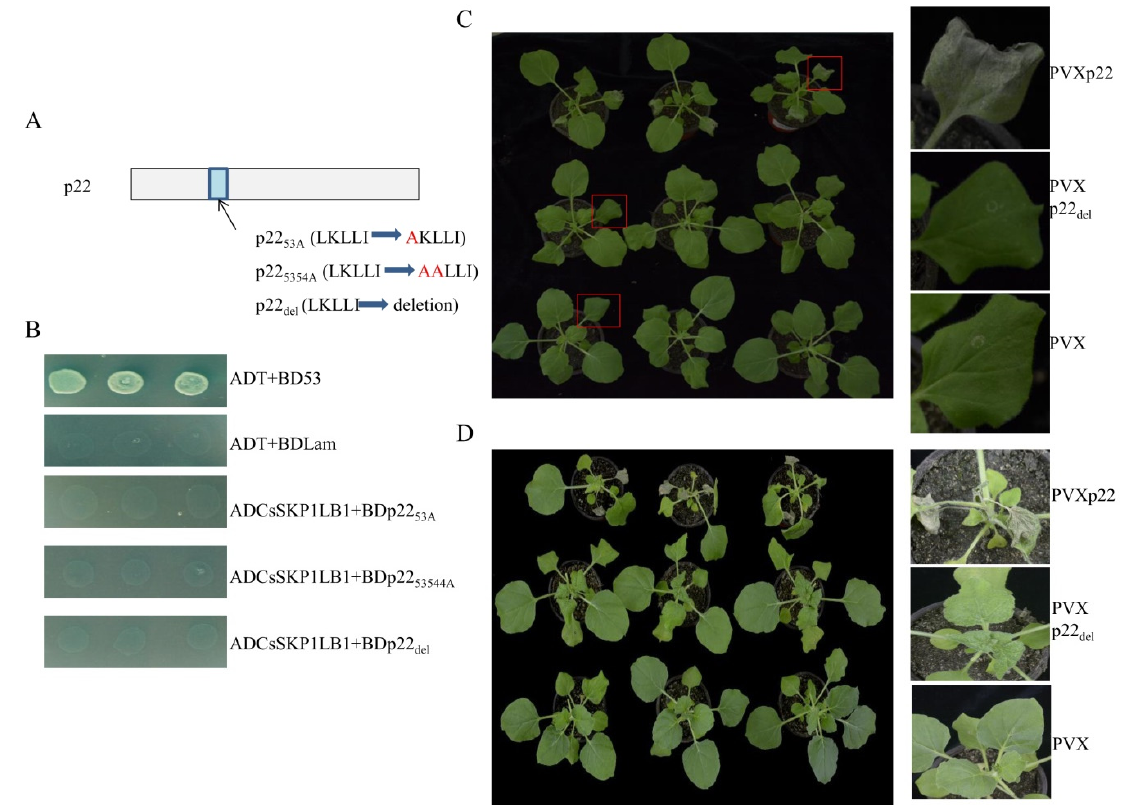
Figure 4. The F-box-like motif is required for the interaction and p22-mediated viral pathogenicity. ( A ) Blue indicates the potential F-box-like motif LKLLI (amino acids 53–57). p22 53A indicates the point mutation at amino acid 53 from L to A. p22 5354A indicates a double mutation at amino acids 53 and 54 fromLKtoAA.p22 del indicatesthecompletedeletionofthefiveaminoacids. ( B )ThegrowthofY2HGold yeast cells co-transformed with ADCsSKP1LB1 and three mutants of p22 (BDp22 53A , BDp22 5354A , and BDp22 del ) on a high-stringency selective medium (SD / -Leu / -Trp / -His / -Ade / Aba / X- α -Gal). ( C , D ) Nicotiana benthamiana leaves treated with the PVX and PVXp22del mutants showed mosaic symptoms similar to those caused by wild-type PVX, whereas PVXp22 caused necrosis of the inoculated leaf, systemic leaf, and vascular tissue. Two di ff erent time points were observed. C, 7 dpi; D, 10